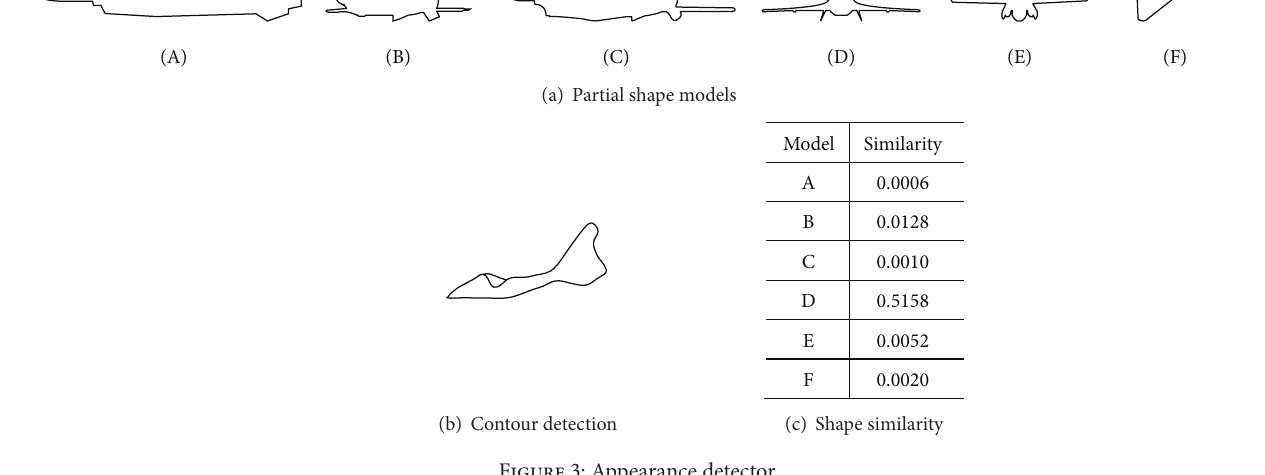
Figure 3: Appearance detector.